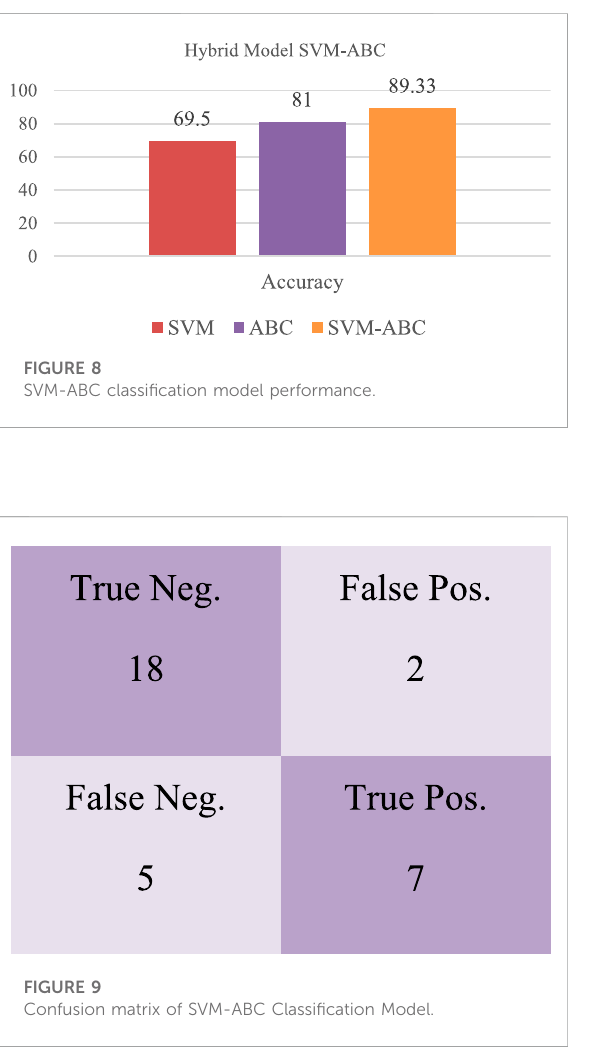
FIGURE 11 The confusion matrix of